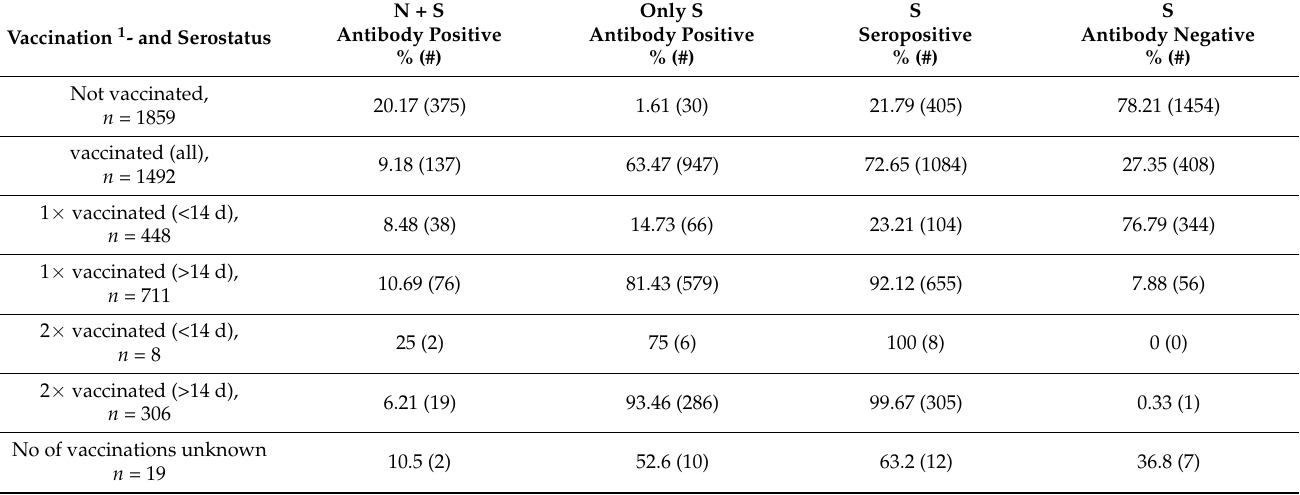
Table 4. Antibody response in vaccinated (self reported) and infected study participants. For the 3351 individuals with a valid questionnaire result for vaccination at FU2, we determined S- and N-antibody seropositivity. Indicated are % (#) of S antibody positive and % (#) N antibody positive among unvaccinated and vaccinated at FU2 (April 2021, based on self-report via questionnaire). We determined the impact of 1 versus 2 vaccinations and also the time interval from vaccination to blood drawl (< versus ≥ 14 days after